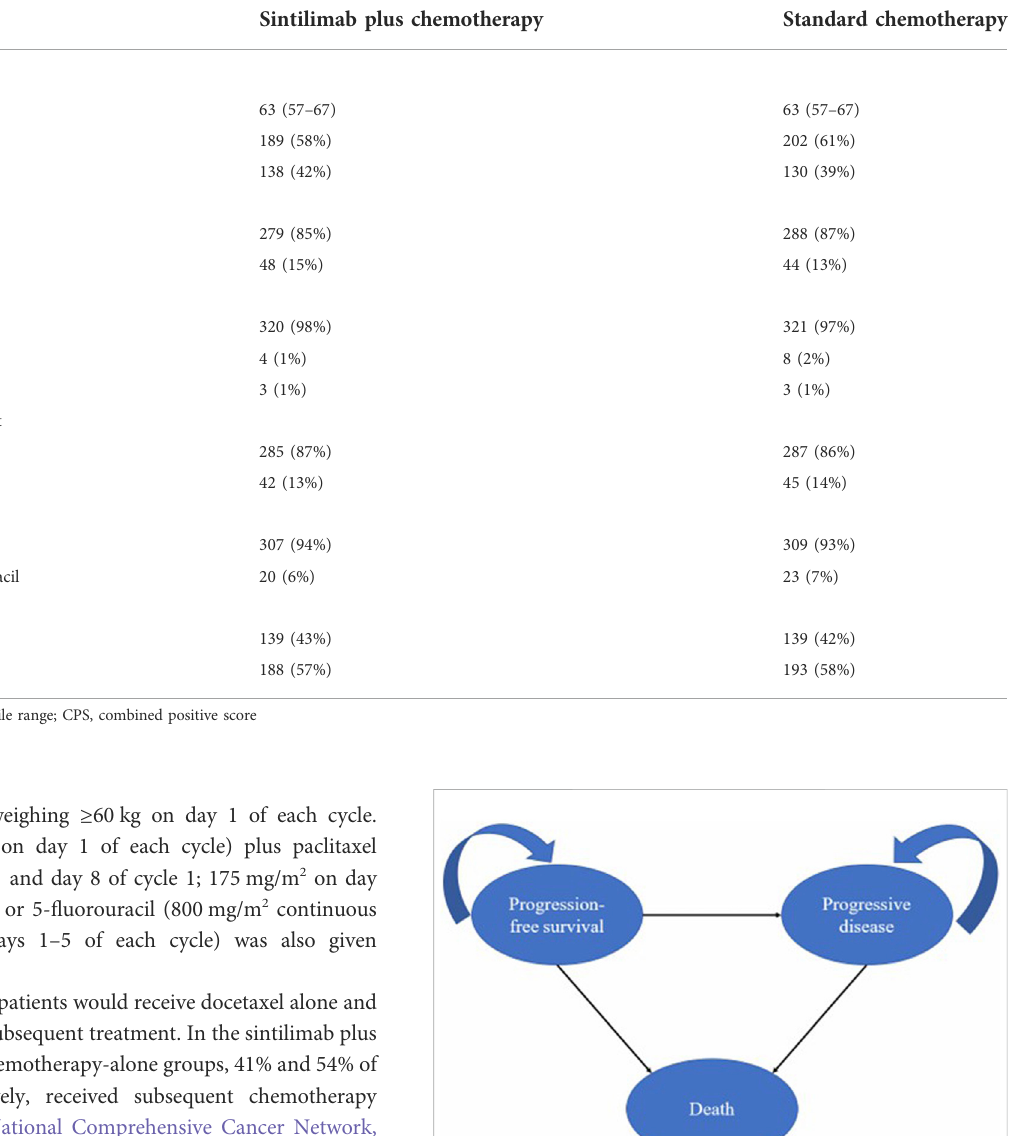
TABLE 1 Baseline characteristics of the